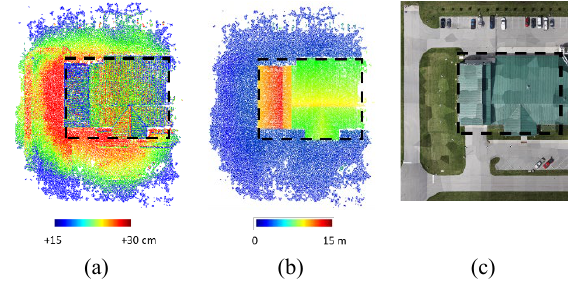
Figure 10. Image-based point cloud colored by (a) Z discrepancy to LiDAR point cloud and (b) height, as well as (c) orthophoto for A-2